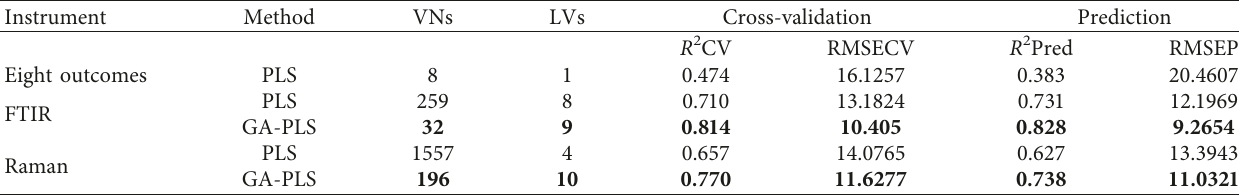
Table 3: Results of PLS and GA-PLS regression model of chronological age estimation. The optimized models are shown in bold. Instrument